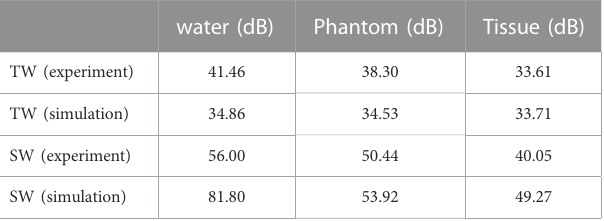
TABLE 4 The pressure focusing gain of TW and SW focusing in different media.